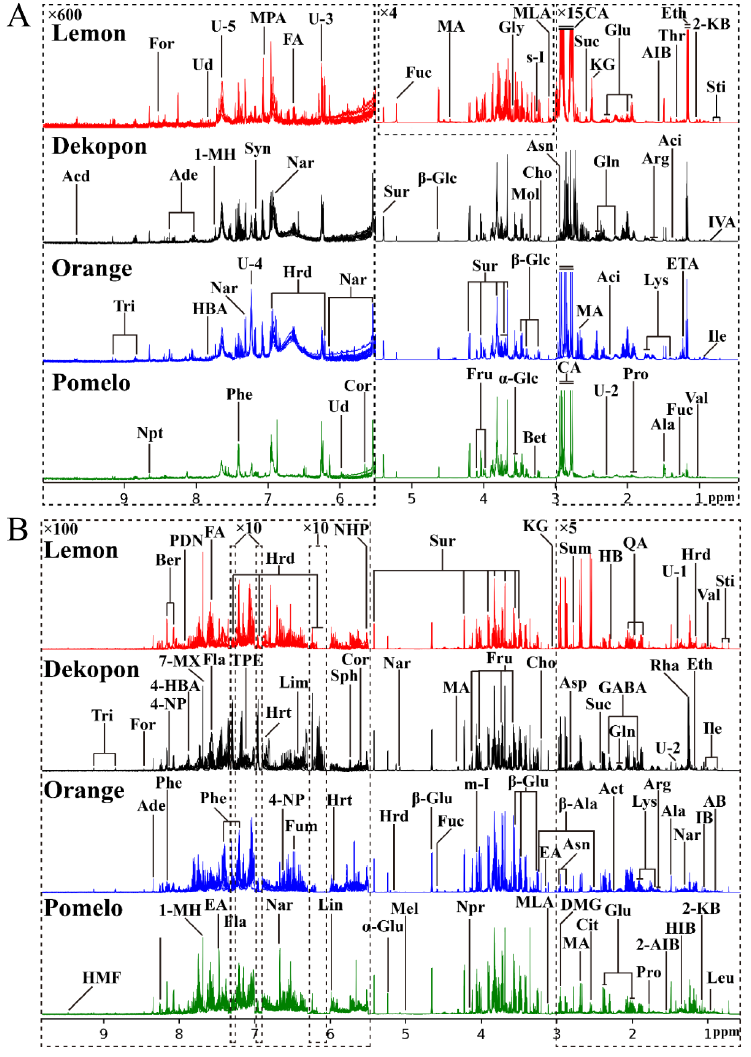
Figure 1. The superimposed 850 MHz 1 H-NMR spectra of the four varieties of citrus juices ( A ) and pericarps ( B ). For clarity, the spectral regions of δ 0.5–3.0 were vertically magnified 15 times and 5 times relative to the spectral regions of δ 3.0–5.5 for the juices and pericarps, respectively. The spectral regions of δ 3.0–5.5 of the lemon juice were vertically magnified 4 times relative to the same spectral region of the other three citrus juices. The spectral regions of δ 5.5–10.0 were vertically magnified 600 times and 100 times relative to the spectral regions of δ 3.0-5.5 for the juices and pericarps, respectively, among which the spectral regions of δ 6.00–6.30, δ 6.90–7.00 and δ 7.31–7.35 for the pericarps were only magnified 10 times. The keys and the detailed spectral information of the identified components are shown in Table 1. These U on the spectra indicate the unassigned signals.